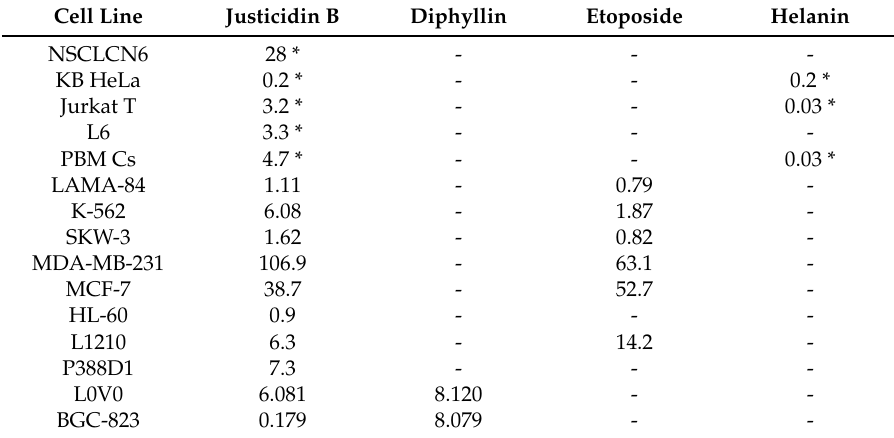
Table 6. Cytotoxicity of justicidin B against selected tumor cell